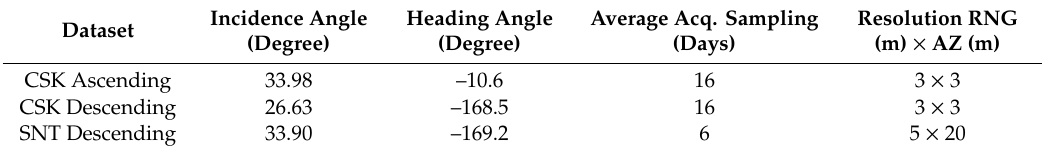
Table 1. Characteristics of the COSMO-SkyMEd (CSK) and Sentinel-1A / B (SNT) dataset used in this study. Heading angles are calculated positive clockwise from north. Table S1 shows acquisition dates and perpendicular baselines of each